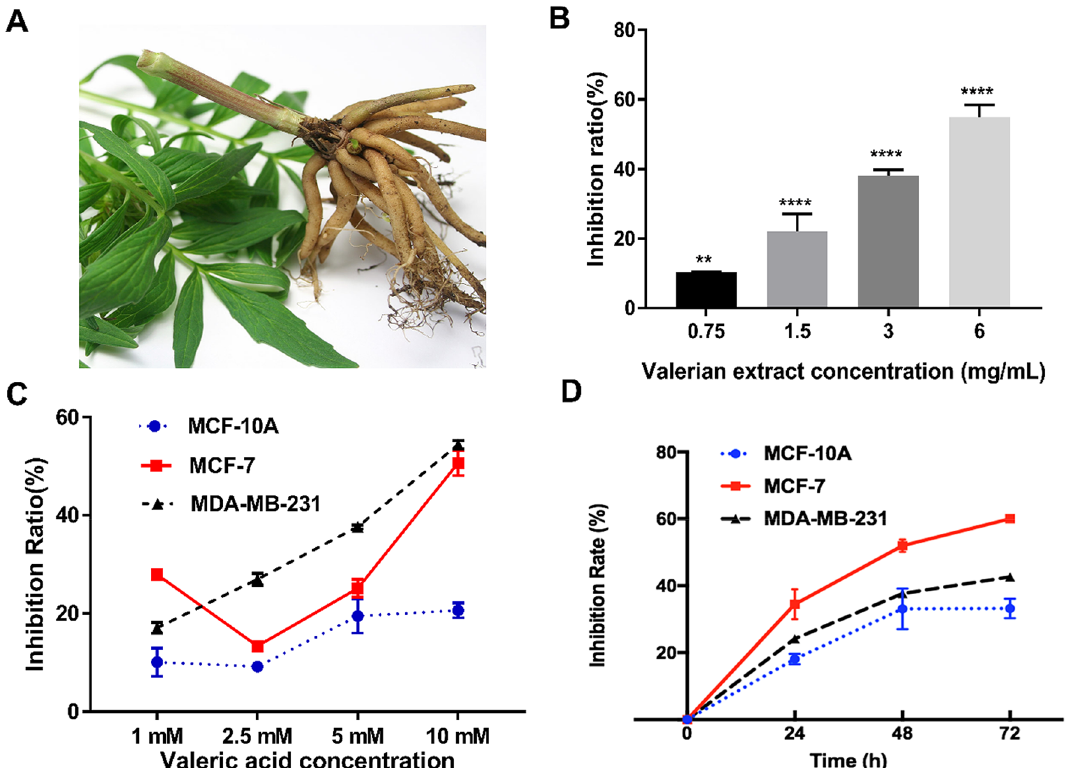
Figure 1. Cell proliferation inhibitory effect of valerian extract and valeric acid on breast cancer cells. ( A ) A picture of Valerian root. ( B ) Valerian inhibited the growth of MCF-7 cells in a dose-dependent manner. MCF-7 cells were incubated with valerian extract in different concentrations (0.75 mg/mL, 1.5 mg/mL, 3 mg/ mL, and 6 mg/mL) and significant inhibition of cell proliferation was observed after 48 h. ( C ) Cell proliferation inhibitory effect of valeric acid on MCF-7, MDA-MB-231 and MCF-10A cells at different concentrations (1 mM, 2.5 mM, 5 mM, and 10 mM) and the inhibition of cell proliferation was measured after 48 h. ( D ) Cell proliferation inhibitory effect of valeric acid on MCF-10A, MDA-MB-231 and MCF-7 cells at 24 h, 48 h, and 72 h. Cells were incubated with 5 mM of valeric acid and all experiments were performed in